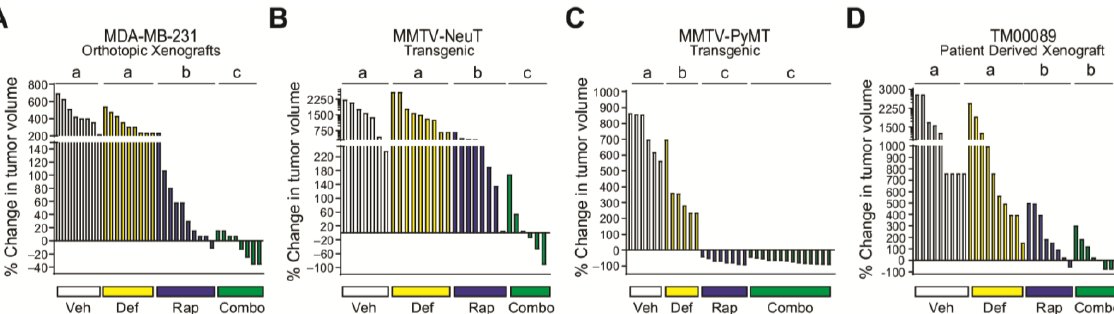
Figure 5. FAK blockade restores sensitivity to mTORC1 inhibition in resistant tumors. ( A ) Waterfall plot of MDA-MB-231 tumors in NSG mice treated with vehicle (Veh), rapamycin (Rap), defactinib (Def), or the combination (Combo, 1:1 ratio) for 14 days. Calculated percent change was based on the tumor size at day 14 compared to the initial tumor size at day 0. Each bar represents one tumor; 5 mice/group with 1 – 2 tumors/mouse. Groups with the same letter are not statistically different; groups with different letters are statistically different at p < 0.05. ( B ) Waterfall plot of MMTV-NeuT transgenic mouse tumors transplanted into FVB/N female mammary fat pads and treated as in ( A ) for 21 days. ( C ) Waterfall plot of MMTV-PyMT transgenic mouse tumors transplanted into FVB/N female mice and treated as in ( A ) for 15 days. ( D ) Waterfall plot of TM00089 PDX tumors in NSG mice treated as in ( A ) for 30 days. a,b,c,d: groups with the same letter are not statistically different; groups with different letters have a p -value < 0.05.